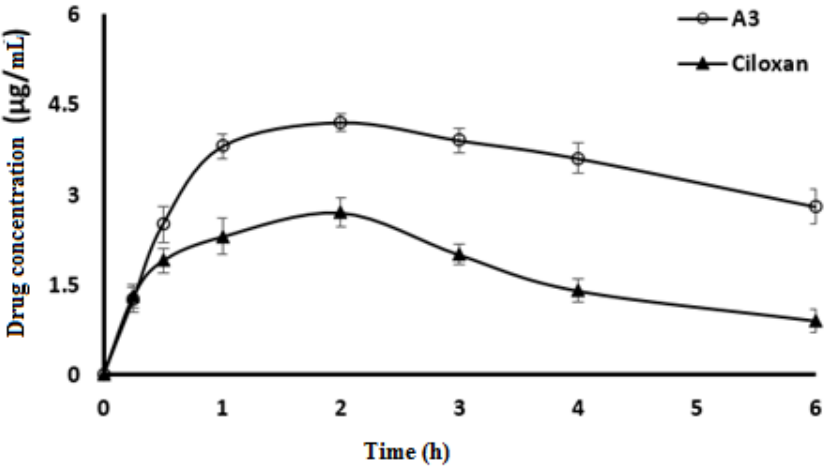
Figure 5. CPX concentrations in rabbit aqueous humor for ophthalmic CPX-CLBF (A3) compared with commercial one (mean ± SD, n = 6.0). Table 2. Pharmacokinetics parameters of ophthalmic CPX- CLBF (A3) and commercial one (mean ± SD, n = 3.0).